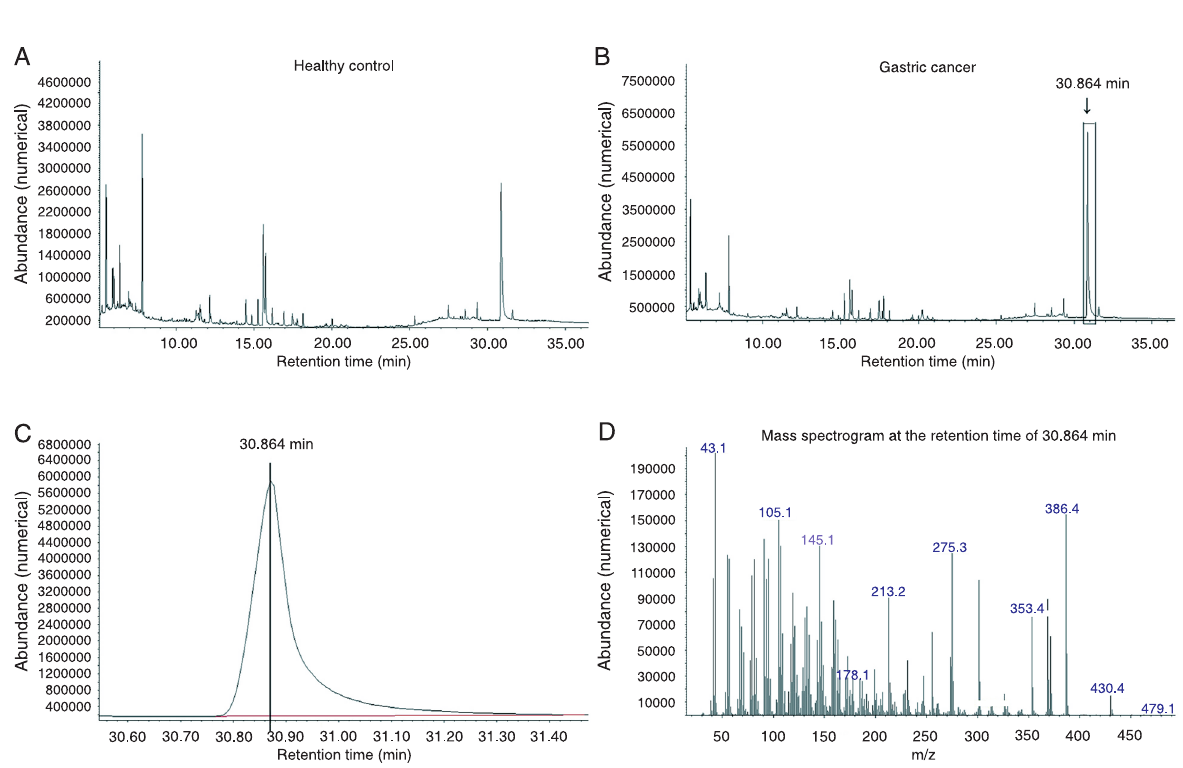
Figure 1. Typical gas chromatography/mass spectrometry (GC/MS) total ion current (TIC) chromatograms. A and B show that, within one TIC chromatogram, over 60 signals were usually detected in a single gastric cancer serum or normal control serum specimen. C shows a base peak at the retention time of 30.864 min that was extracted and magnified. D shows that the mass spectrogram at the peak summit was selected and compounds were identified via mass spectral match to the National Institute of Standards and Technol - ogy library. The m/z values of the first three highest abundance of fragmentation patterns were 43.1, 105.1, and